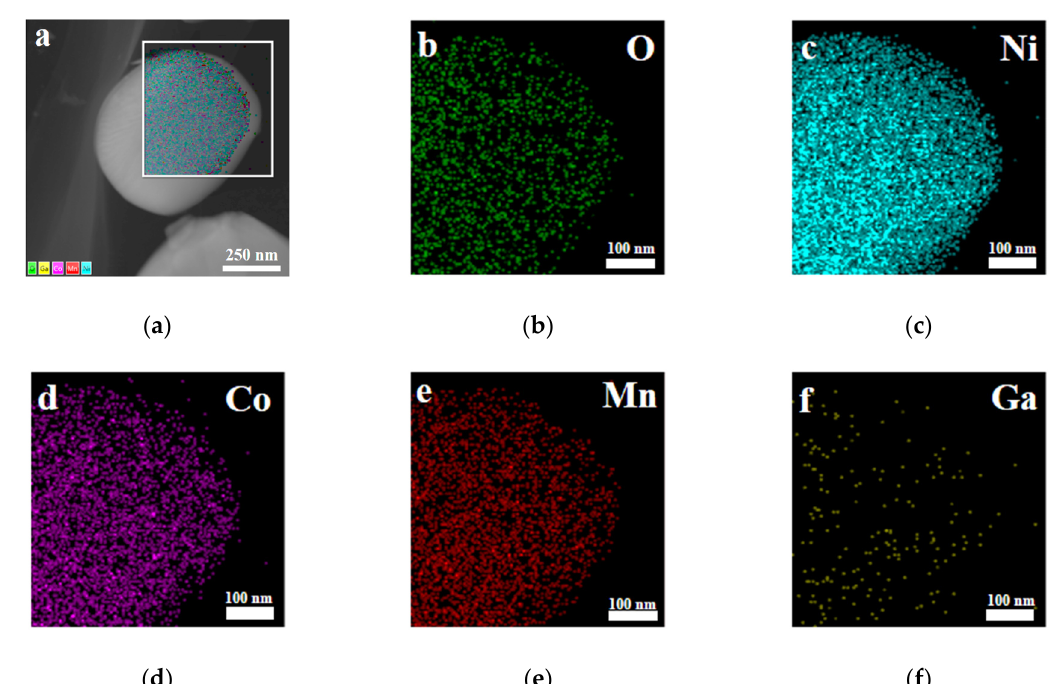
Figure 6. Energy dispersive X-ray (EDX) spectroscopy mapping of Li[Ni 0.6 Co 0.2 Mn 0.2 ] 0.98 Ga 0.02 O 2 . ( a ) Layered image; ( b ) O atoms; ( c ) Ni atoms; ( d ) Co atoms; ( e ) Mn atoms; ( f ) Ga atoms.